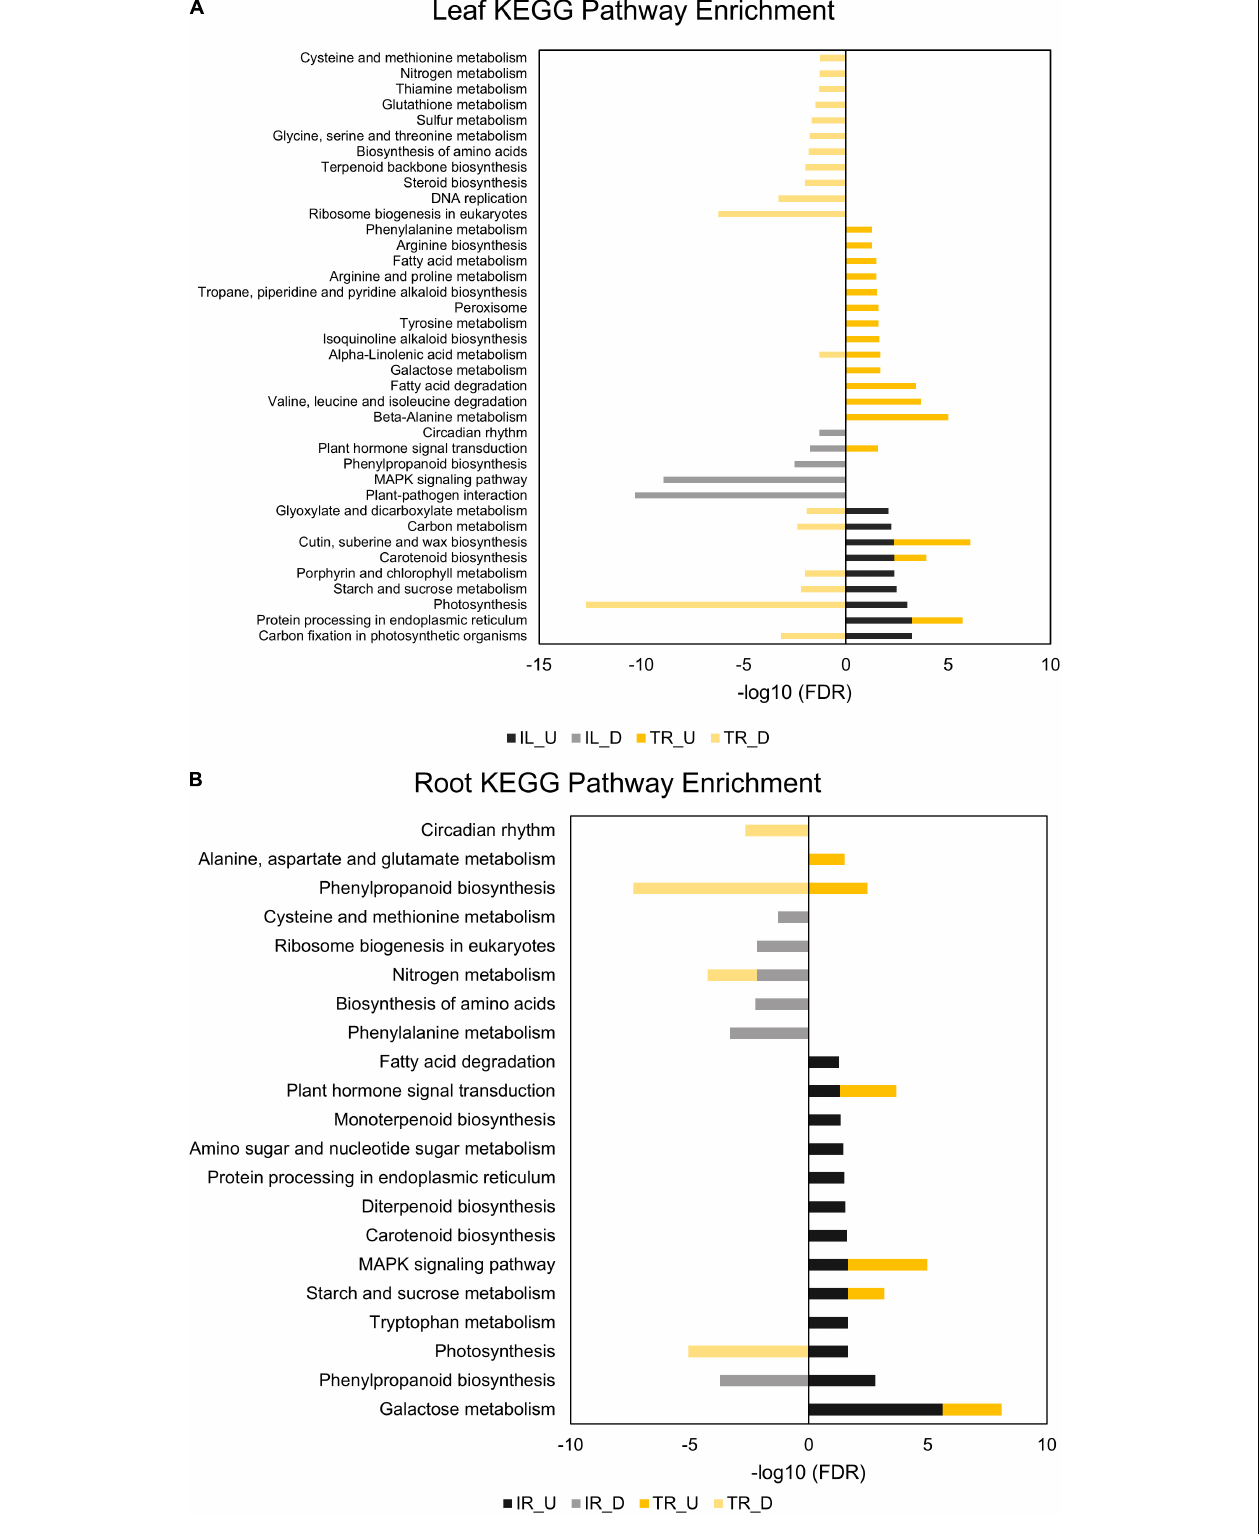
Frontiers in Plant Science |